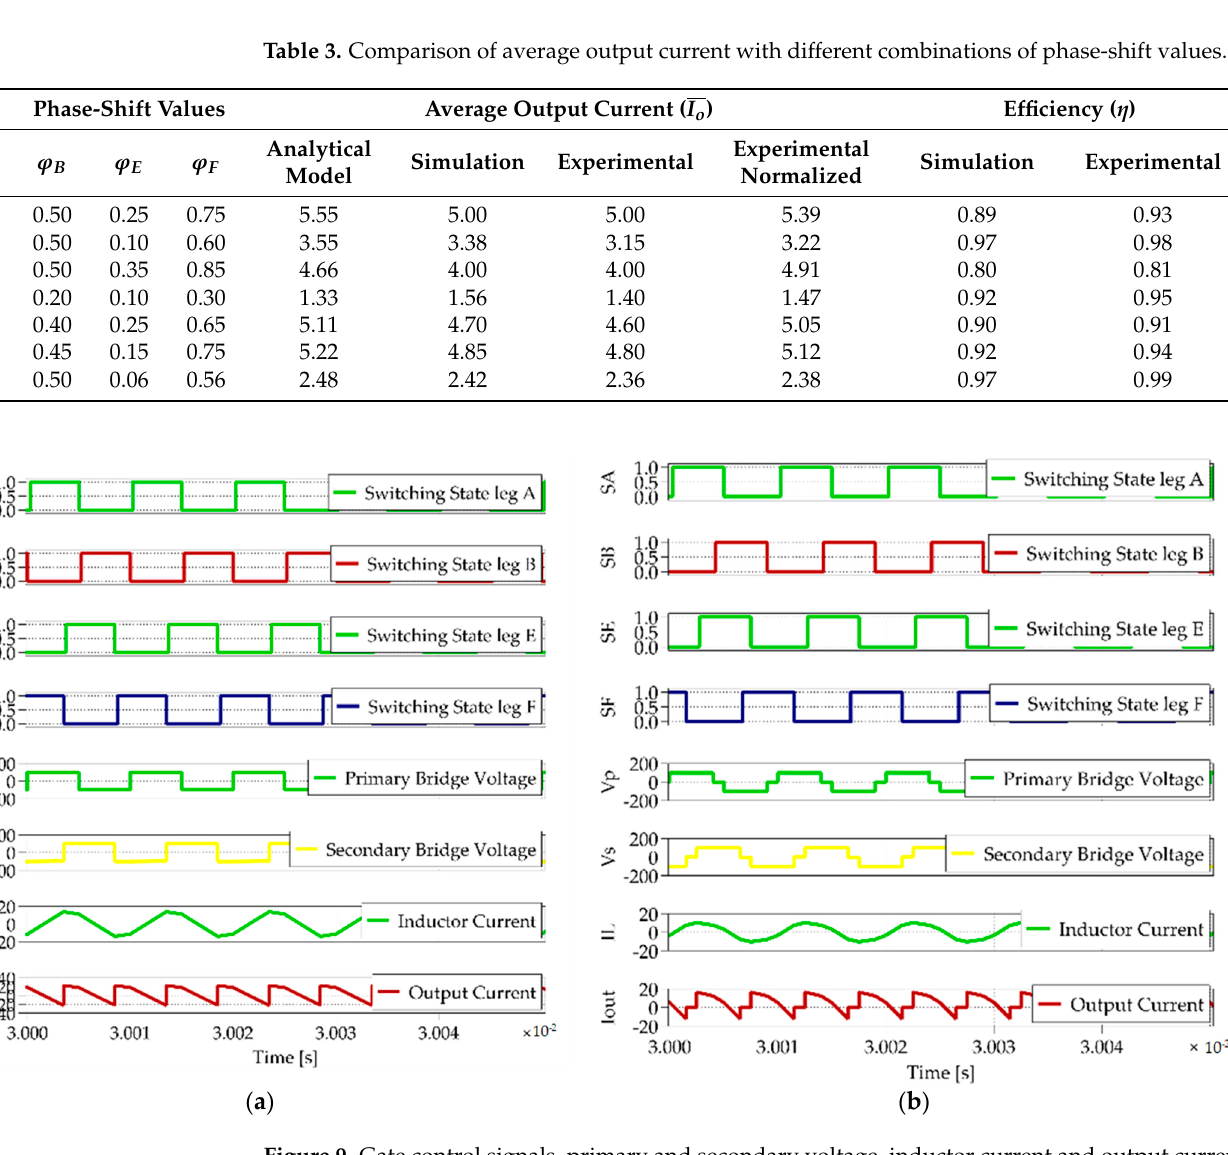
Table 3. Comparison of average output current with different combinations of phase-shift values.